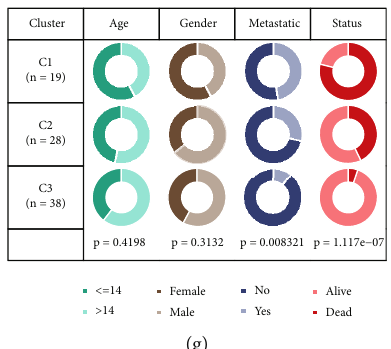
Figure 1: Construction of ARG-based patterns in osteosarcoma from the TCGA cohort. (a) The forest map showed multivariable Cox analysis of prognostic signatures. (b) Consensus cumulative distribution function (CDF) diagram with di ff erent k values. (c) Delta area plot for relative change in the area under CDF curve for k compared to k − 1 . (d) Consensus matrix when number of groups ð k Þ = 3 . In the consensus matrix, white meant that samples were impossibly clustered together, and dark blue meant that samples were always clustered together. Both rows and columns of the matrix represented samples. (e) Kaplan-Meier curves for OS of three molecular subtypes. The survival probabilities were compared with log-rank test. (f) Clustering analysis of the expression of the 36 prognostic ARGs. (g) Comparison of clinicopathological characteristics among the C1, C2, and C3 clusters in the TCGA